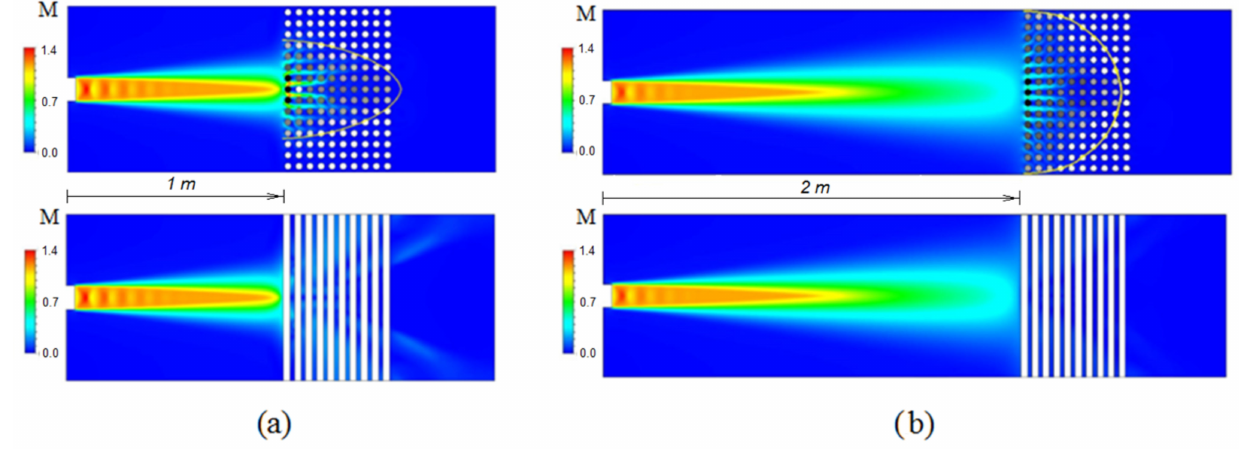
Figure 8. Blowing of the tube package by an air jet with pressure P 0 = 0.235 MPa. ( a ) Case 2; and ( b ) case 6. Upper—XOY plane, lower—XOZ plane.